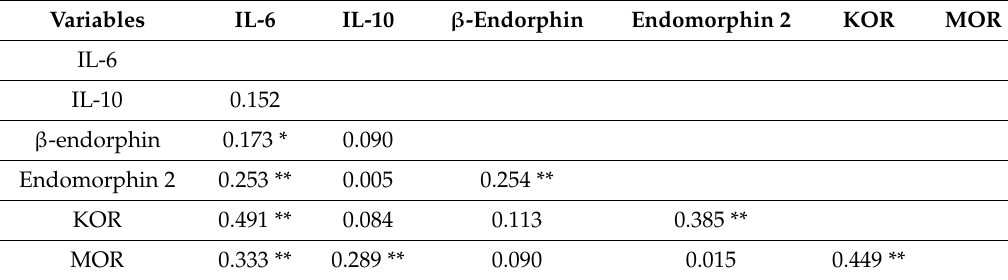
Table 2. Correlation matrix between the biomarkers included in this